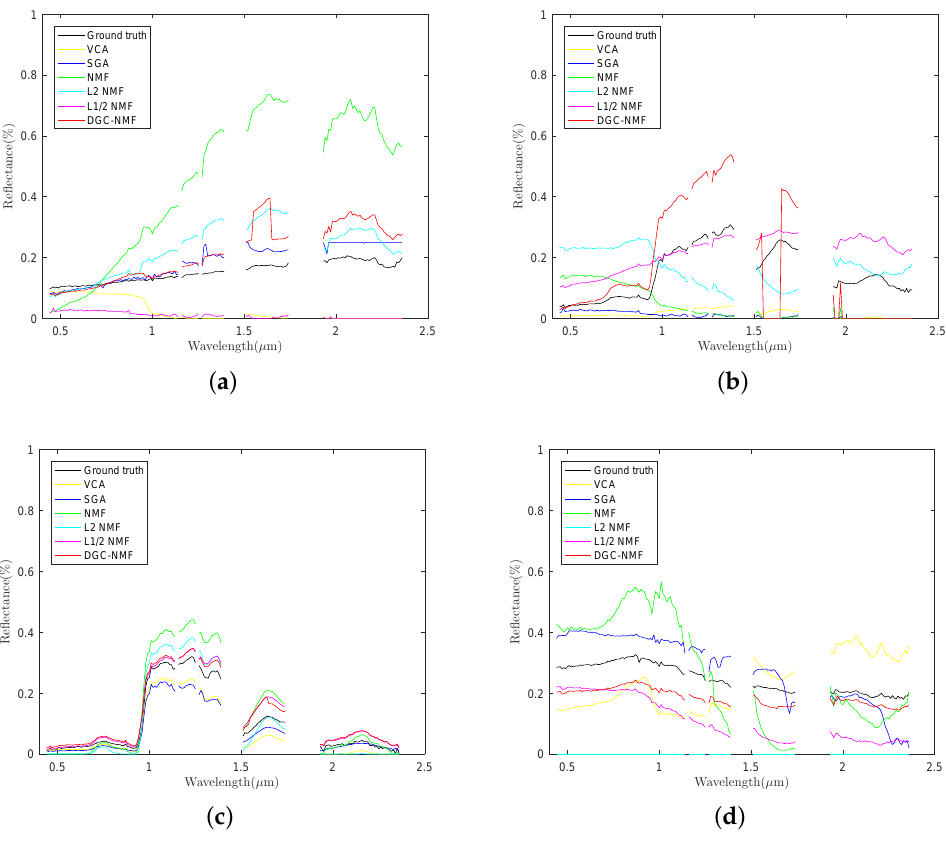
Figure 12. Comparison of endmember signatures estimated by different methods over urban data. ( a ) asphalt; ( b ) grass; ( c ) trees; ( c ) roofs. VCA: vertex component analysis; SGA: simplex growing algorithm.